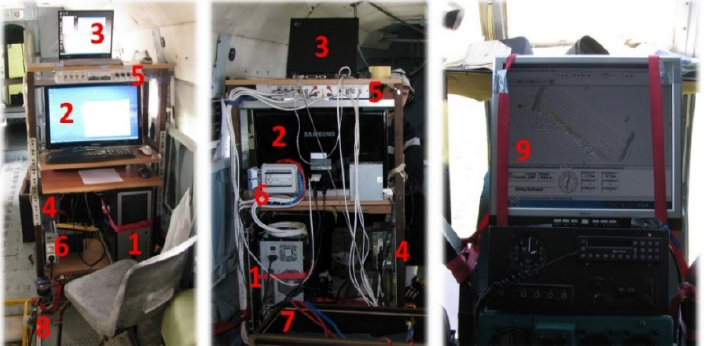
Figure 2. Control table with module control system component inside Mi-8 helicopter: (1) personal computer (PC) for manipulation with Nikon D90 and Photon 320; (2) monitor for PC and industrial controller (switching is performed as needed during recording); (3) laptop for manipulation with inertial measurement unit (IMU); (4) industrial controller for manipulation with MS4100 and ImSpector + PixelFly (not part of the first system configuration, built in 2009); (5) junction box of the electric power system; (6) converter from 28–30 V direct current (DC) to 220 V alternating current (AC) for PC and monitor; (7) large battery (210 Ah, 75 kg) for power supply; (8) cables for connection with sensor; (9) navigation monitor located in the cockpit.